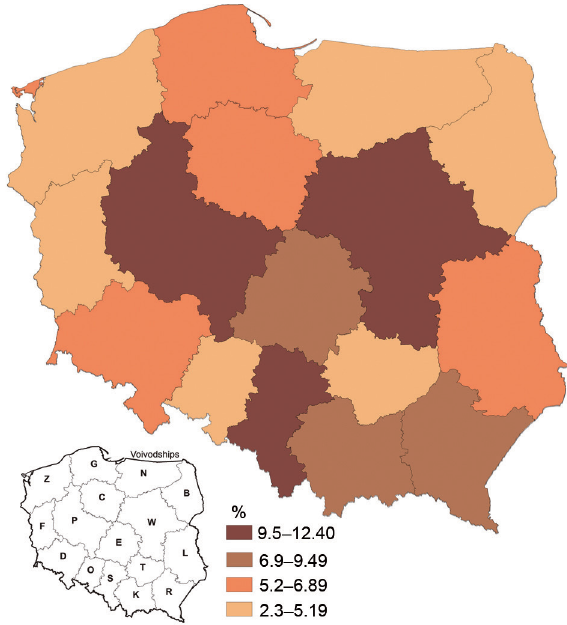
Fig. 1. Public buildings handed over to users in voivode - ships as percentages of all public buildings put into use in Poland in 2011.